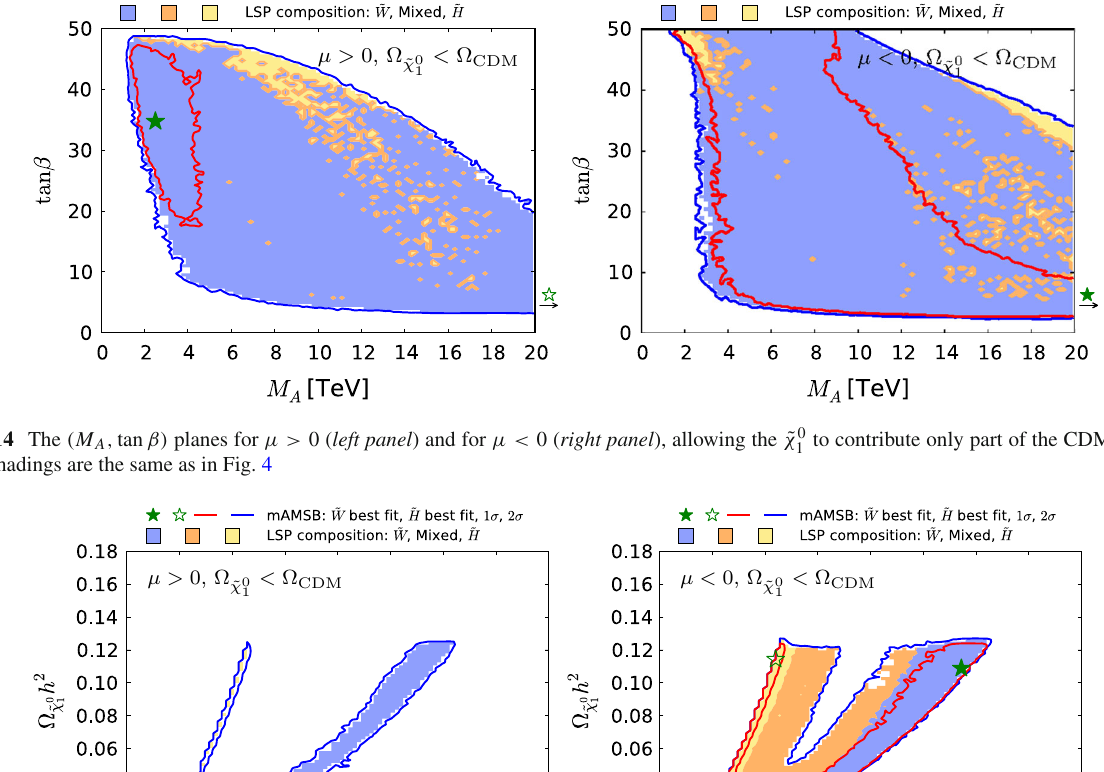
,(cid:4) h 2 ) planes in the mAMSB for μ > 0 ( left ) and μ < 0 ( right ), allowing the ˜ χ 0 Fig. 15 The ( m ˜ χ 0 ˜ χ 0 1 1 The red (blue) contours represent the 68% (95%) CL contours. The shadings are the same as in Fig.